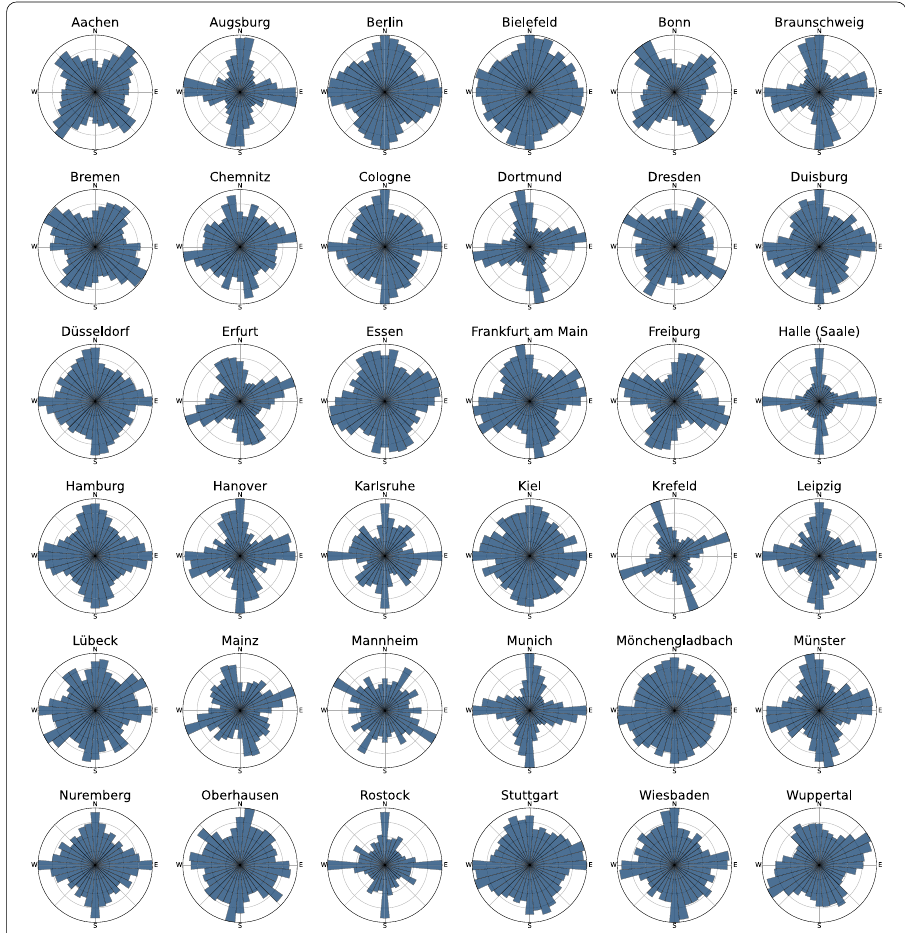
Fig. 2 Street network orientations of the 36 largest German cities with valid GTFS data as described in the "Data" section. The plots were created using the OSMnx python package (Boeing